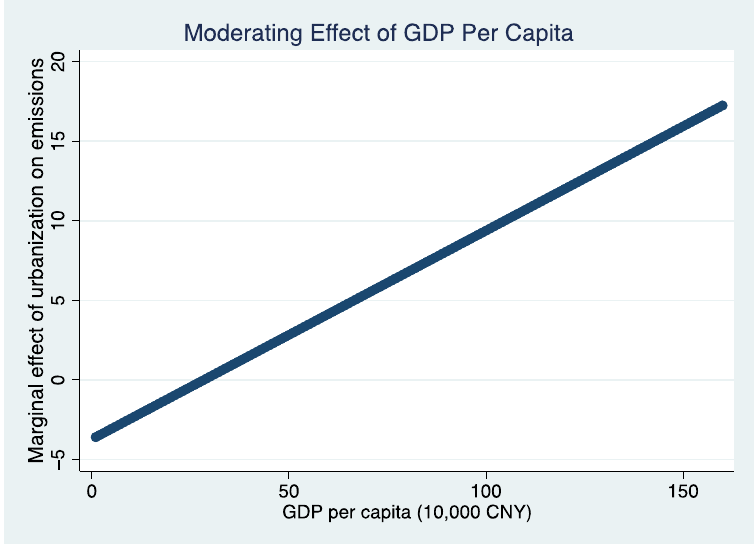
Figure 3. Moderating effect of GDP per capita.